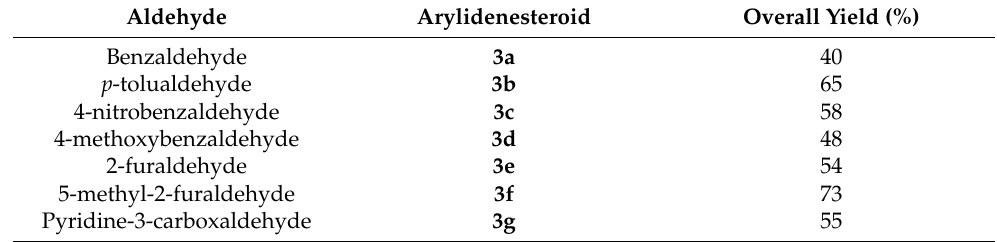
Table 1. New 21-arylidene-4-azapregn-5-ene derivatives synthesized, and respective overall yields (%). 1.